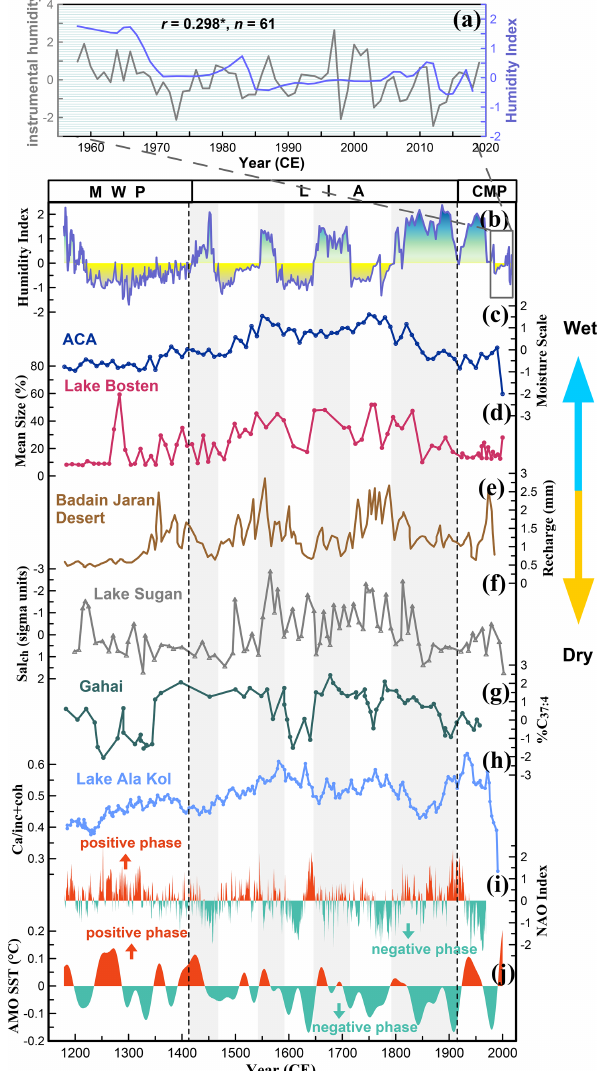
Figure 6. Humidity index (HI) of Lake Dalongchi and compari- son to other records in ACA over the last millennium. (a) Compar- ison between the HI (blue line) and the standardized instrumental effective humidity recorded by Bayanbuluk meteorological station (grey line). An asterisk ( ∗ ) represents the 0.05 significance level. (b) The reconstructed HI for the past millennium (1180–2018CE). (c) The synthesized moisture curve over the last millennium in ACA (Chen et al., 2010). (d) Variations in the mean grain size along the BST04H core in Lake Bosten (Chen et al., 2006). (e) The unsatu- rated recharge history in Badian Jaran (Gates et al., 2008; Ma and Edmunds, 2006). (f) Chironomid inferred salinity (Salch) in SG03I of Sugan Lake (Chen et al., 2009). (g) %C 37 : 4 from Lake Gahai (He et al., 2013). (h) Ca / inc + coh from Lake Ala Kol (Rousseau et al., 2020). (i) The reconstructed NAO (Ortega et al., 2015). (j) The reconstructed AMO (Wang et al., 2017). Light grey bars highlight intervals of increased humidity in Lake Dalongchi during the